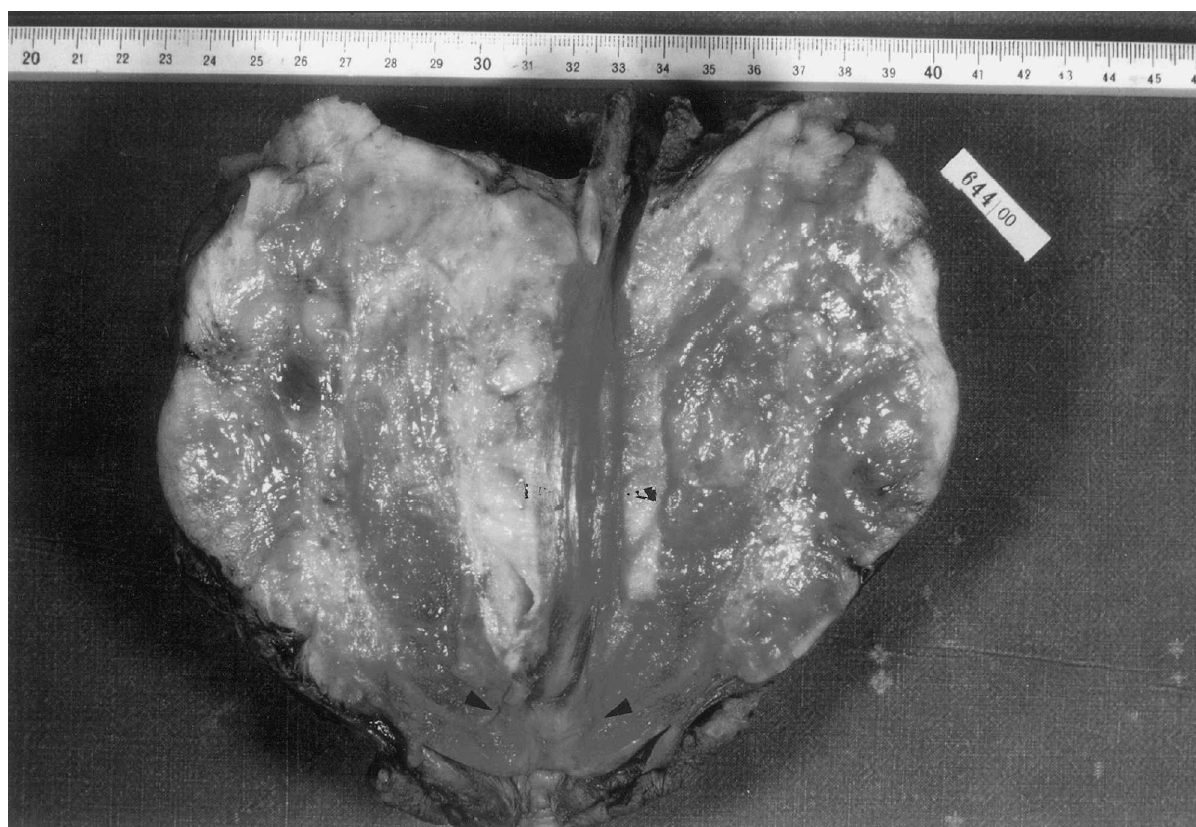
Fig. 1. Macroscopic view of the excised tumor, arrowheads indicating the glans penis at the bottom. Note that the urethra is free of invasion.The tumor size is estimated to be approximately 18 cm.